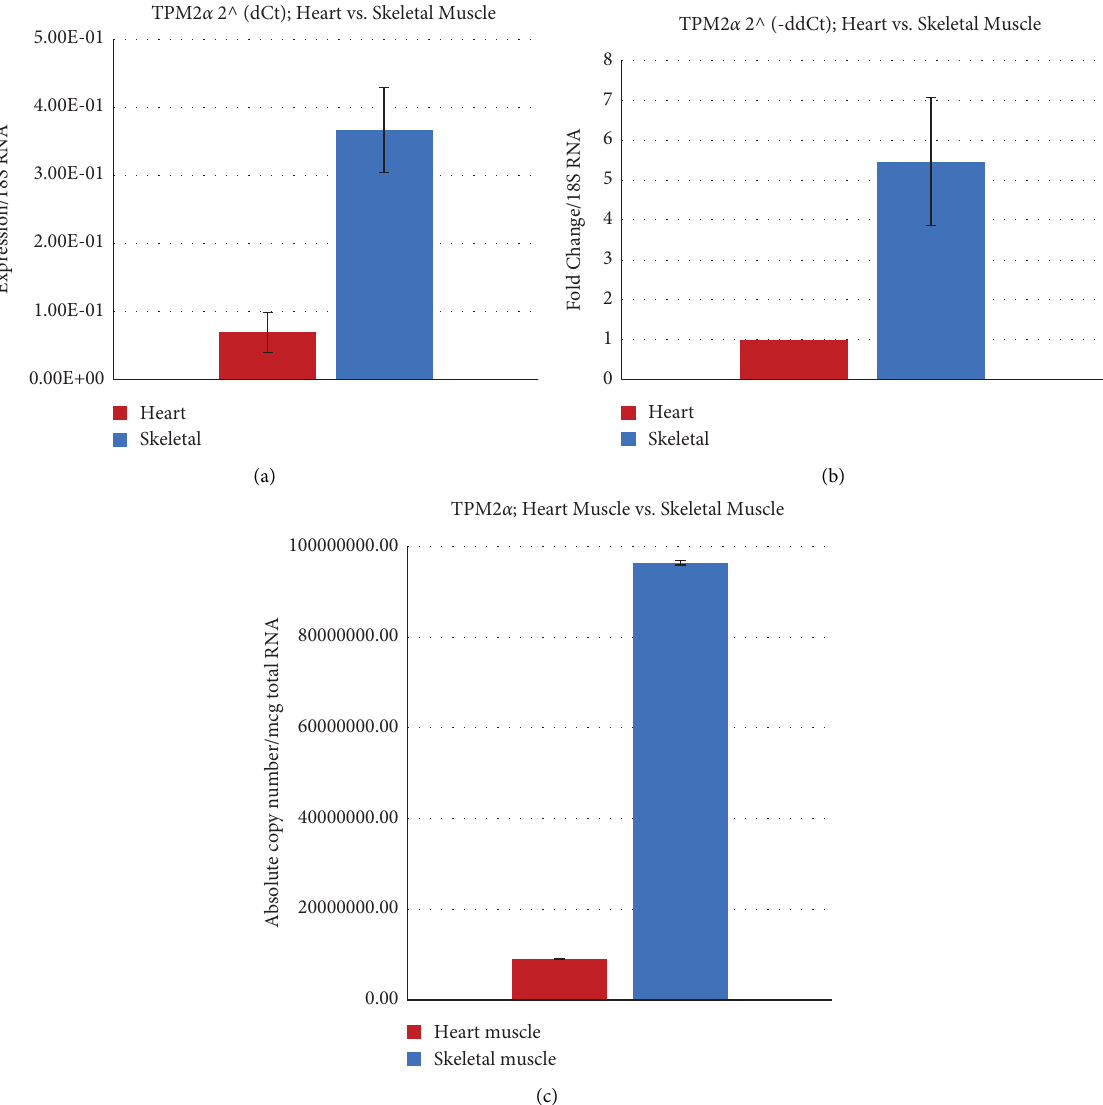
cDNA from human and Cyn RNA were made with the same oligonucleotide(s) and amplifed with the same primer pair.